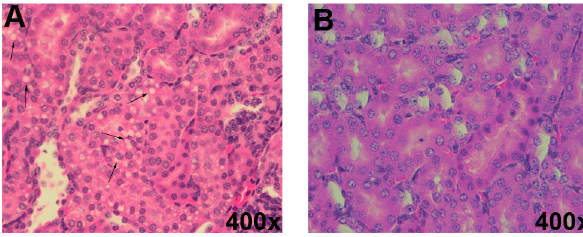
Figure 9. Oral ricin intoxication causes vacuolated tubules in the kidneys of some mice. Excised kidneys from mice orally exposed to ricin (A) or PBS (B) for 24 hours were sectioned and stained with H&E. Black arrows indicate vacuolated tubules. Vacuolation was noted in kidneys of 2/5 mice euthanized at 24 hours post exposure and in one additional mouse that died shortly before the designated time for euthanasia (48 hours). Magnification: 400X.